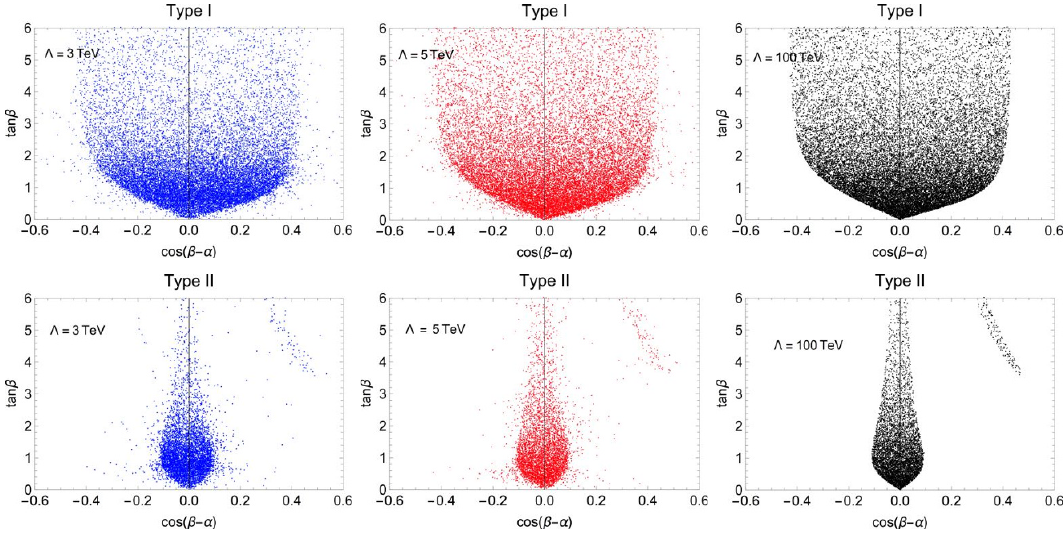
Figure 5 . The top plots show the allowed regions for the type-I model and the bottom plots show the allowed regions in the type-II model. The blue (red, black) points shown are used for the (cid:3) = 3(5 ; 100) TeV cases. Values of the curvature scalar couplings, (cid:24) 1 ; (cid:24) 2 were allowed to